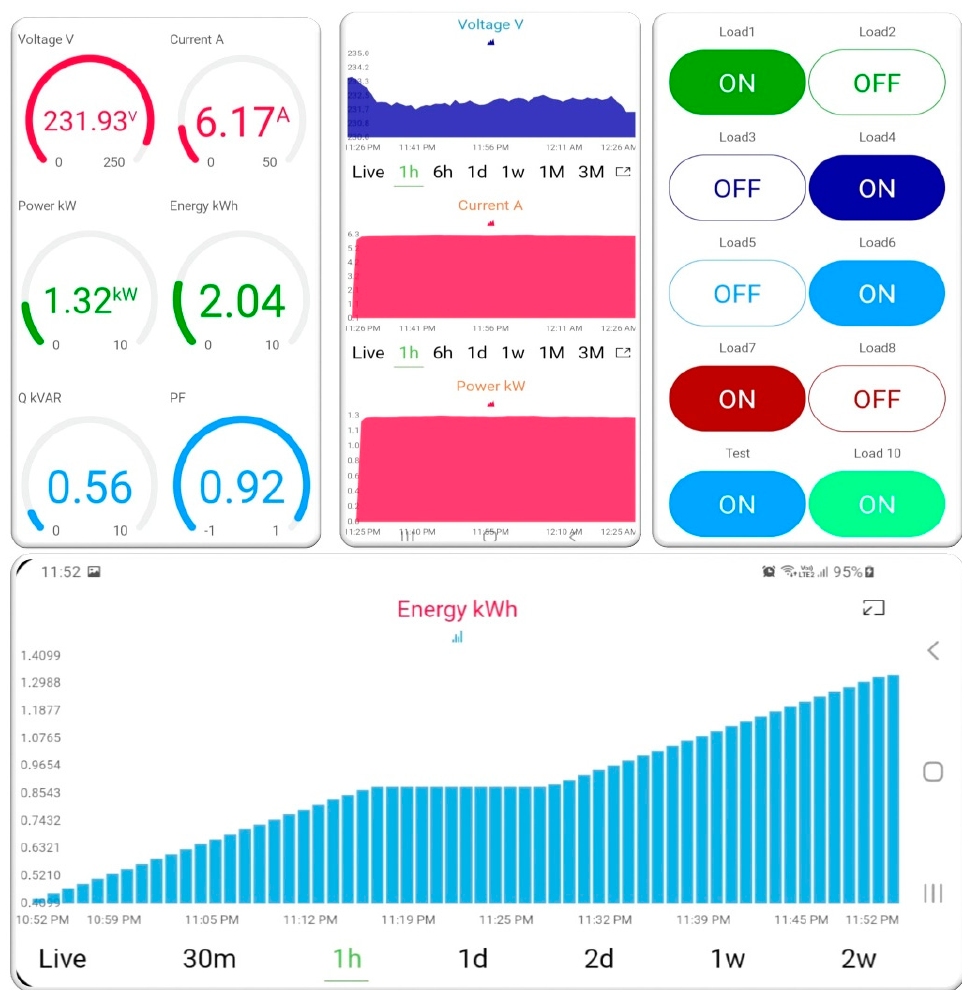
Figure 3. Blynk mobile application dashboard for DPB load monitoring and controlling.